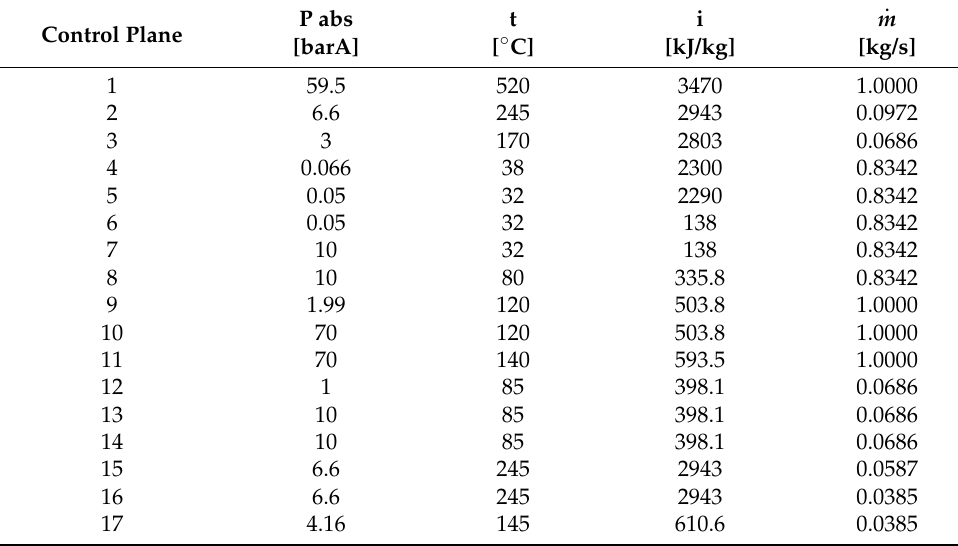
Table 3. Thermodynamic parameters of the working fluid in control planes of the reference